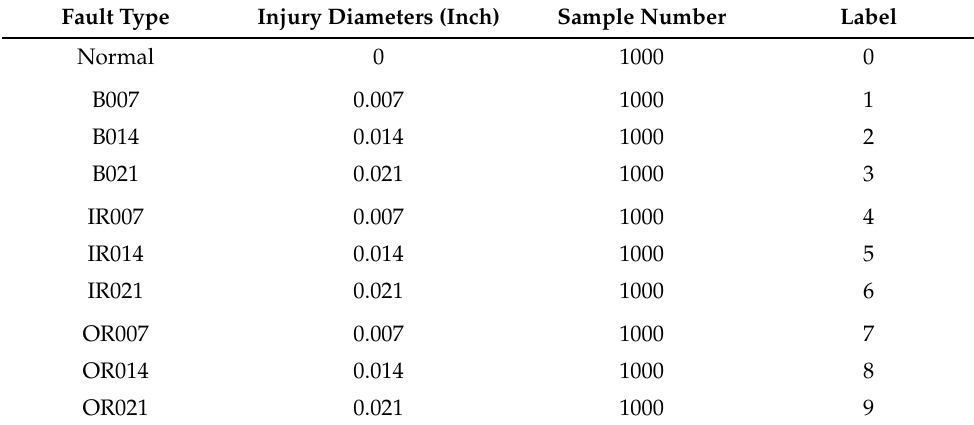
Table 1. Conditions of the rolling bearing dataset.